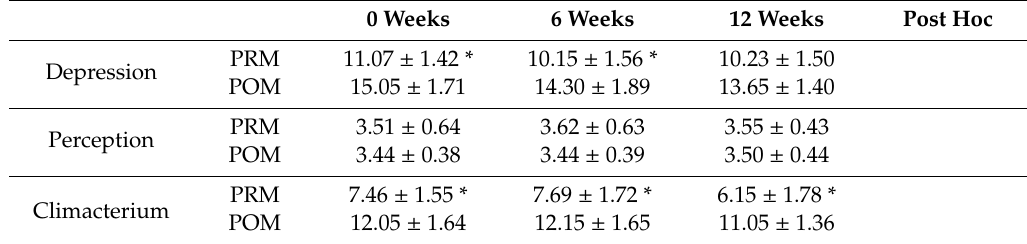
Table 5. Changes in depression, perception, and the climacterium after exercise program. 0